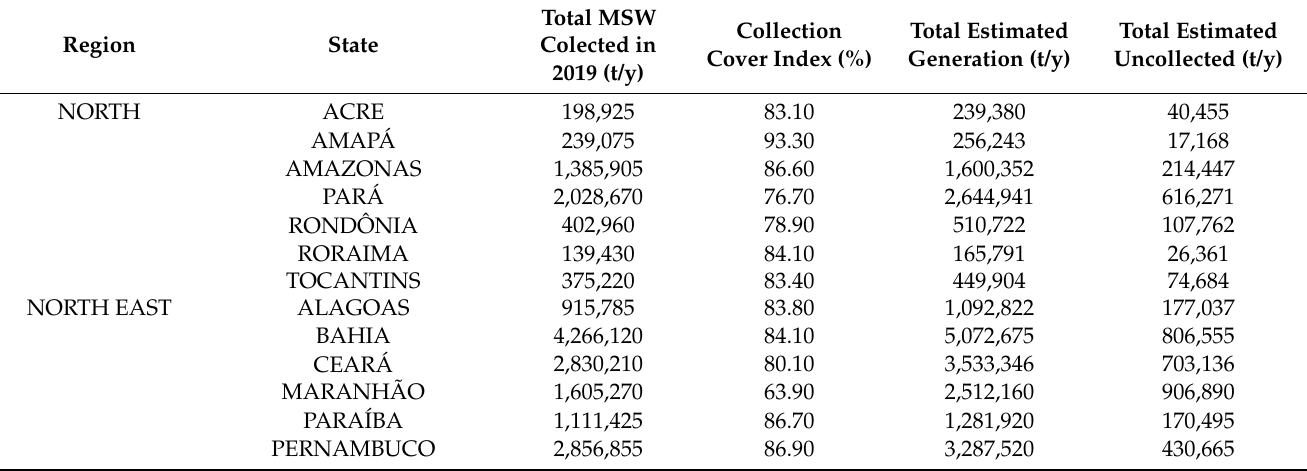
Table 1. MSW collection in Brazilian states by region and collection coverage rate ([3], adapted by the